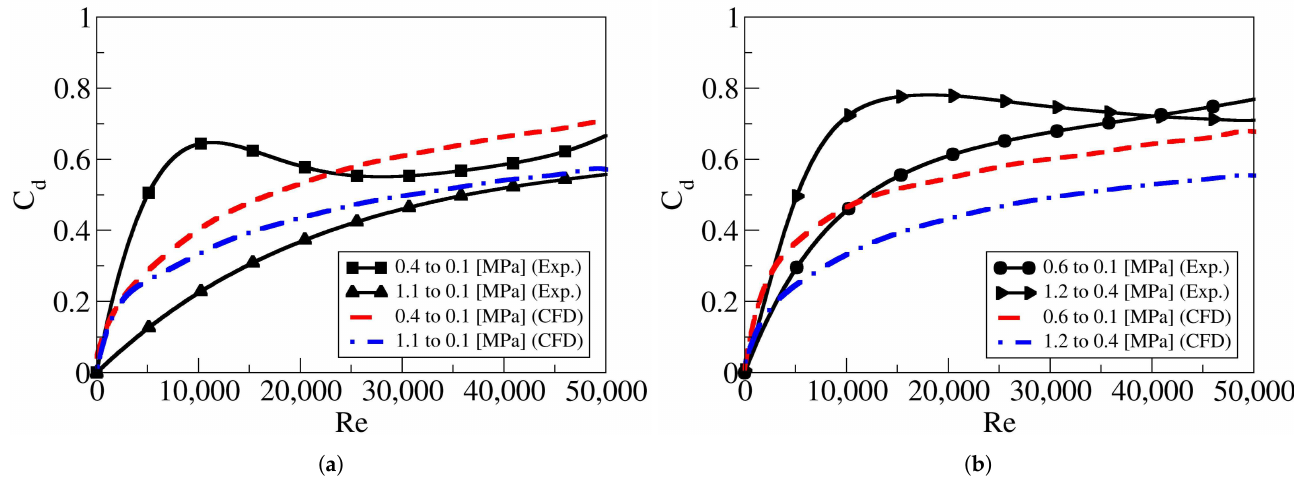
Figure 10. Nozzle discharge coefficient based on experimental data and for all pressures studied. ( a ) Flow from large to small reservoir. ( b ) Flow from small to large